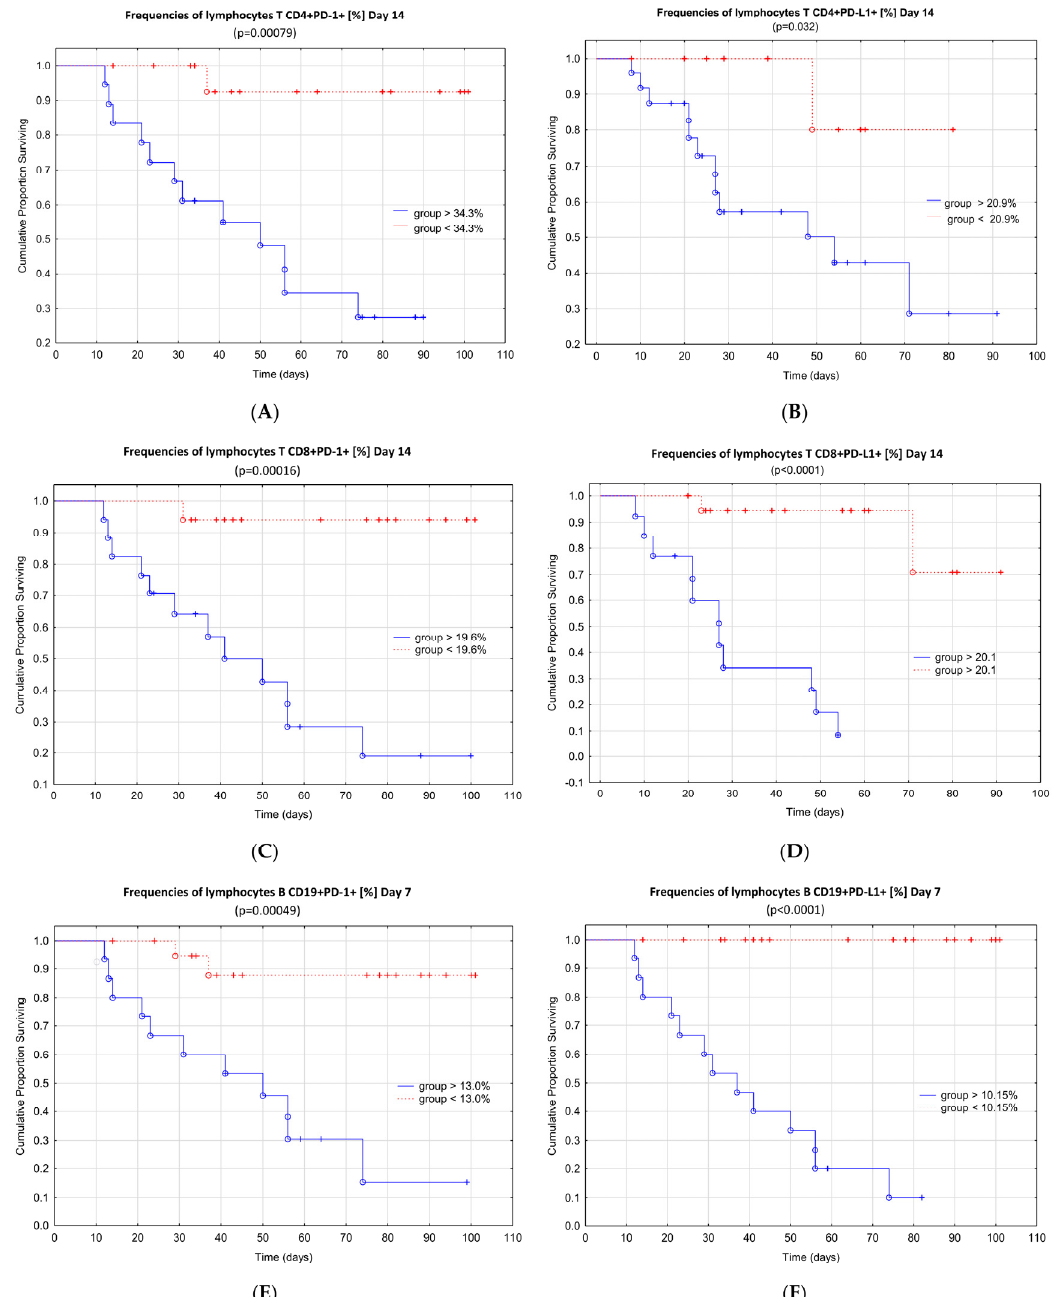
Figure 2. Kaplan–Meier curves illustrating the probability of survival in ICU patients with COVID-19 depending on the percentages of ( A ) CD4+PD-1+ T cells on day 14; ( B ) CD4+PD-L1+ T cells on day 14; ( C ) CD8+PD-1+ T cells on day 14; ( D ) CD8+PD-L1+ T cells on day 14; ( E ) CD19+PD-1+ B cells on day 7; and ( F ) CD19+PD-L1+ B cells on day 7. Percentage of cell subset associated with survival was selected for this analysis.